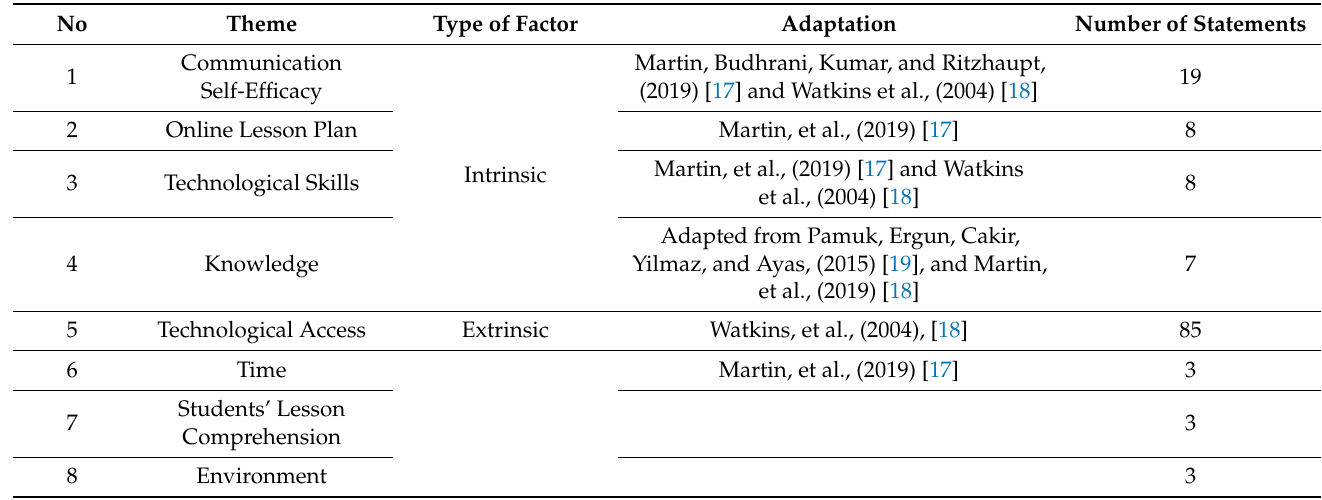
Table 1. Pre-determined and emerging themes and their number of statements.